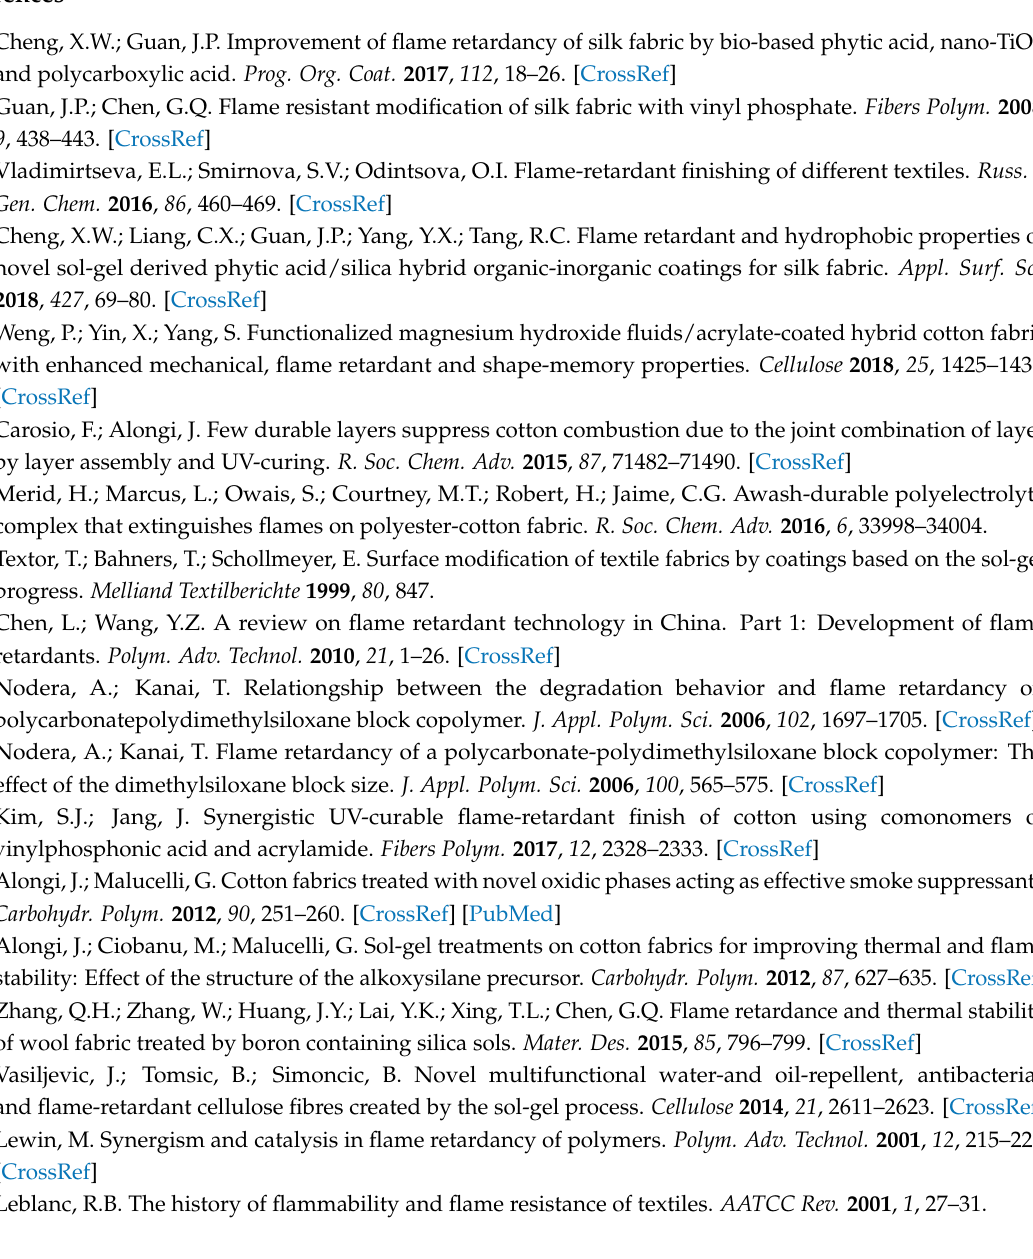
s1, Figure S1: The Pyrolysis gas chromatography of the original silk and finished silk (Si-B, Si-N 1 and Si-N 2 , Si-N 3 , Si-P 1 and Si-P 2 ), Table S1: Name, code and chemical structures of sol-gel precursor and synergist agents, Table S2: Total dry solids add-on of sols on silk samples, Table S3: The pyrolysis gas chromatography of Silk, Table S4: The pyrolysis gas chromatography of Si-B, Table S5: The pyrolysis gas chromatography of Si-N 1 , Table S6: The pyrolysis gas chromatography of Si-N 2 , Table S7: The pyrolysis gas chromatography of Si-N 3 , Table S8: The pyrolysis gas chromatography of Si-P 1 , Table S9: The pyrolysis gas chromatography of Si-P 2 , Table S10: The main peaks description about FTIR spectra of all